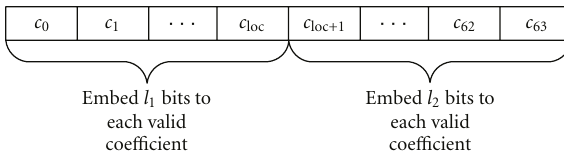
Figure 1: Division of 64 coe ffi cients in a 8 × 8